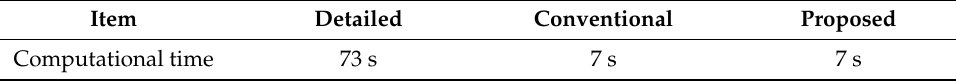
Table 4. Comparison of computational time according to speed variation.